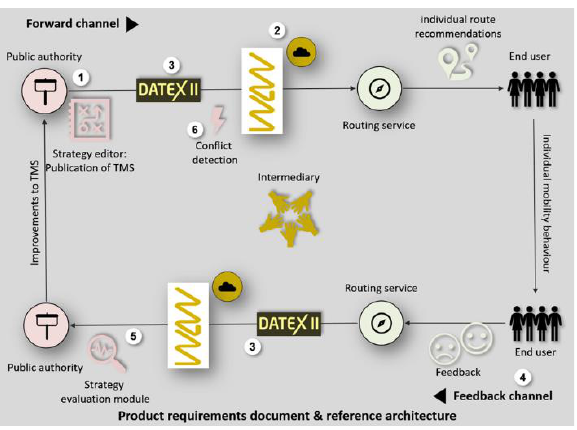
Figure 2. Interaction of the components of the C2N